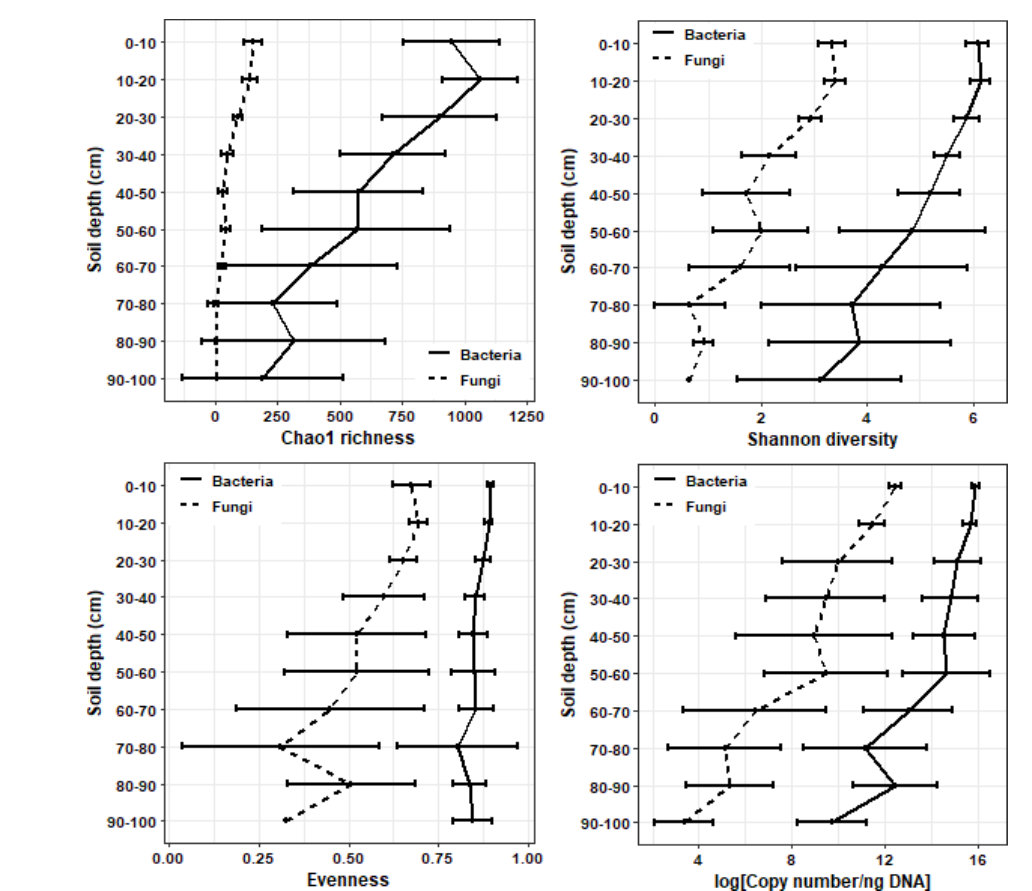
Figure 3. The mean ± SD changes in microbial richness, Shannon diversity, Pielou’s evenness, and 16S rRNA/ITS copy number with soil